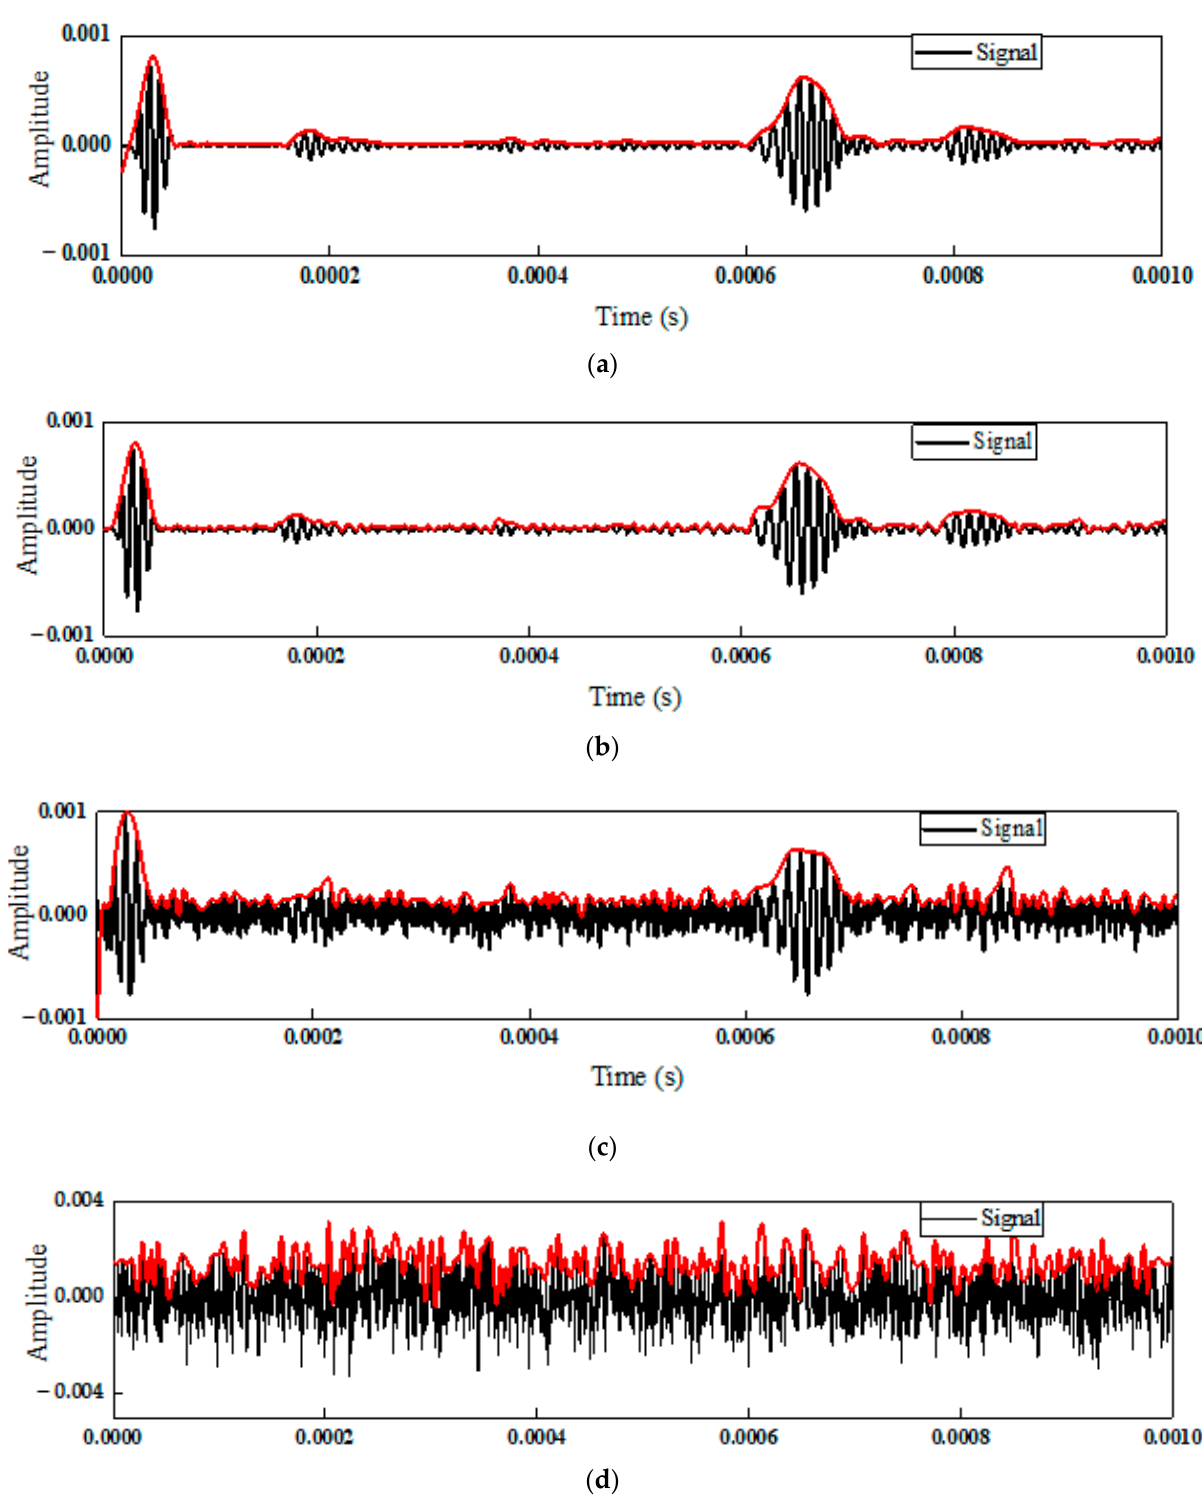
Figure 15. Signals with different noise levels. ( a ) Original signal; ( b ) SNR = 100 dB; ( c ) SNR = 80 dB; ( d ) SNR = 60 dB.